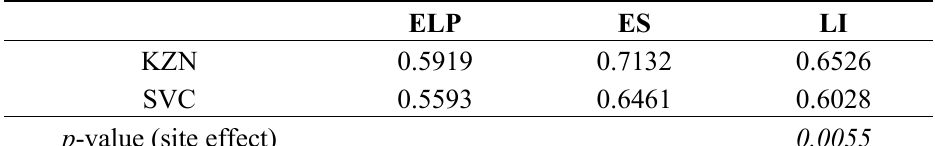
Table 6. Means of overall ES and ELP sub-indices across sites. ES, Ecosystem Services; ELP, Ecoagriculture Landscape Performance; KZN, KwaZulu-Natal; SVC, Savé Valley Conservancy.